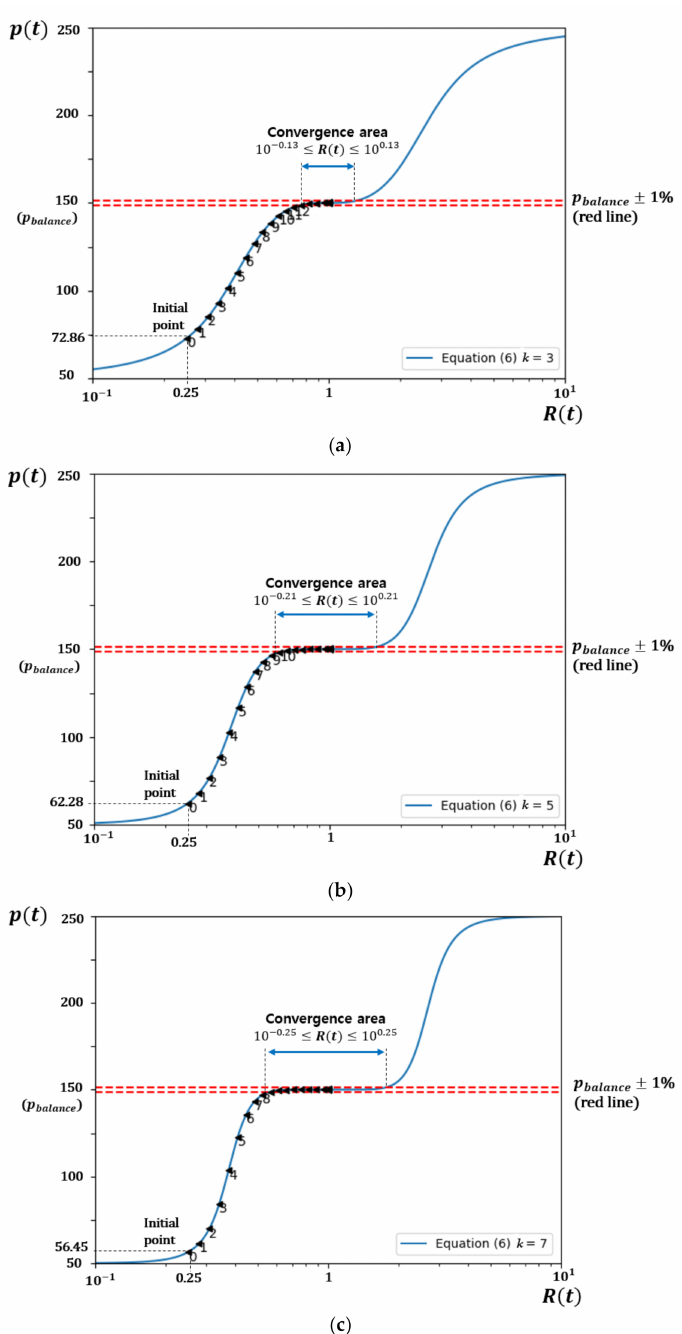
Figure 12. p ( t ) vs. R ( t ) using Equation (6), p balance = 150 and p con = 100, ( a ) k = 3, ( b ) k = 5 and ( c ) k =